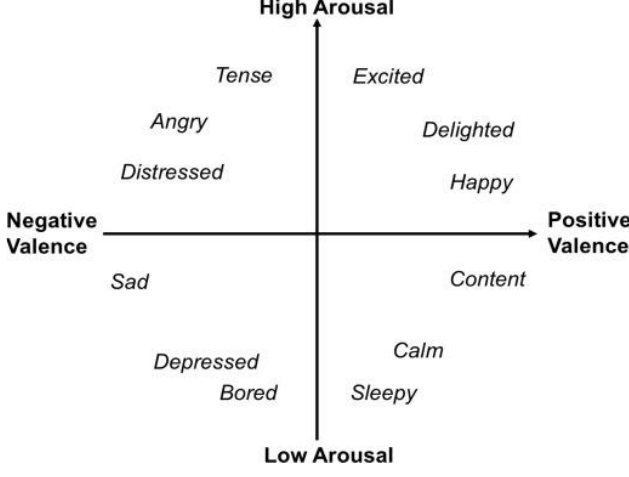
Figure 1. Russell’s circumplex model of affect [20].